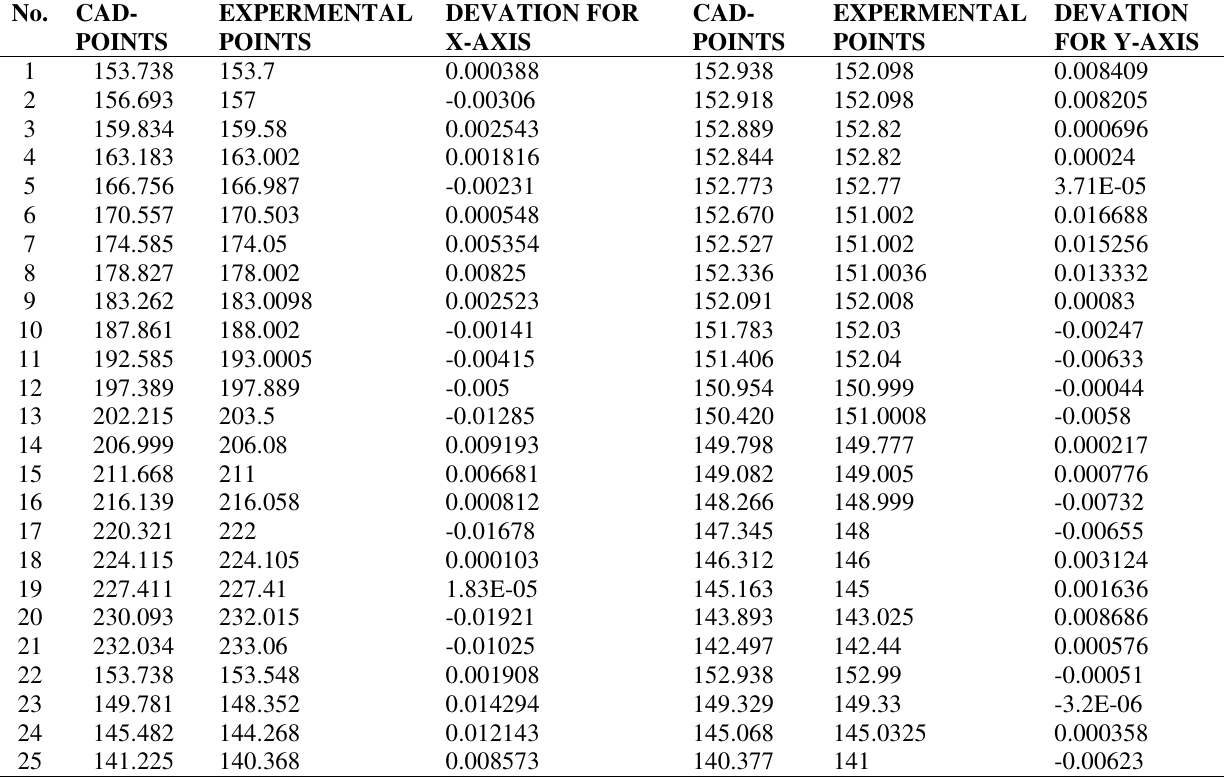
The compression and difference values in dimensions between the proposed and original part.